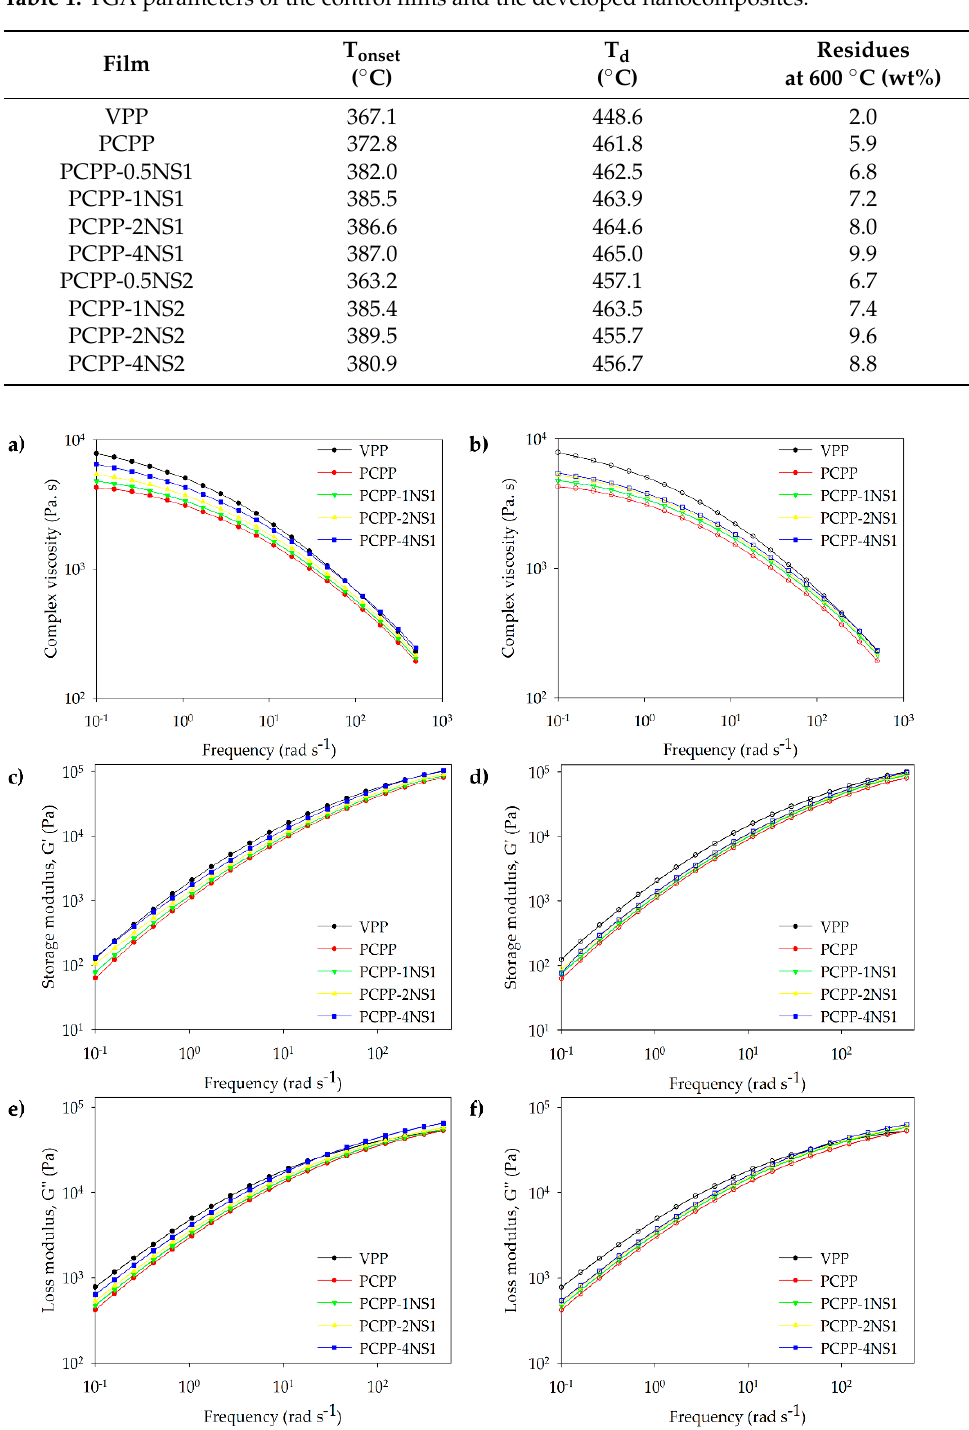
Table 1. TGA parameters of the control films and the developed nanocomposites.